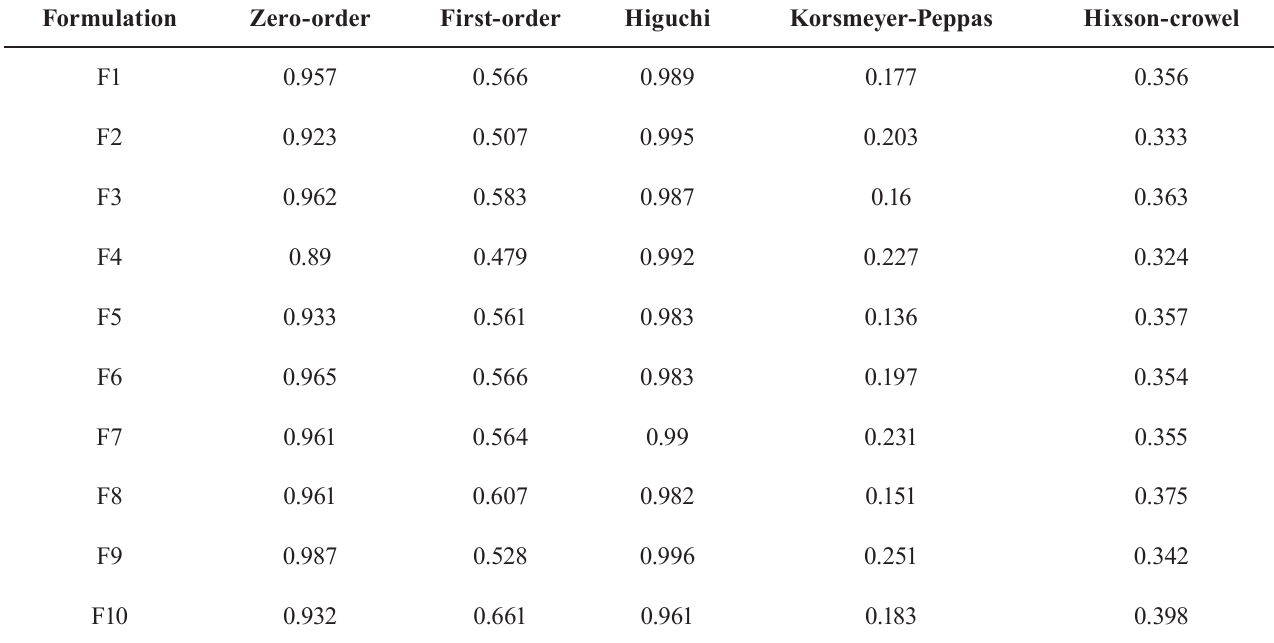
Table VI - In-vitro release kinetics of the formulations